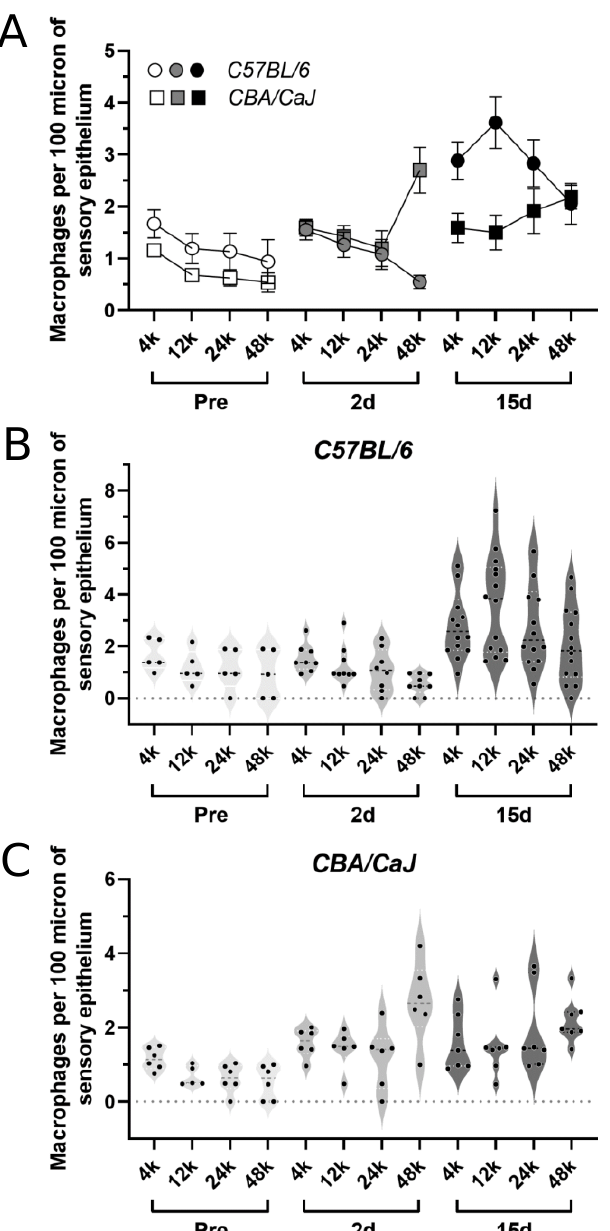
Figure 3. 400 G/200 F treatment modified macrophage density differentially in the basilar membrane. ( A ): Average macrophage density at multiple frequency locations before, 2 days after, and 15 days after the treatment, in B6 (circles) and CBA (squares) mice. Error bar = SEM. ( B ): Violin plots of macrophage density from individual B6 mice. ( C ): Violin plots of macrophage density from individual CBA mice.